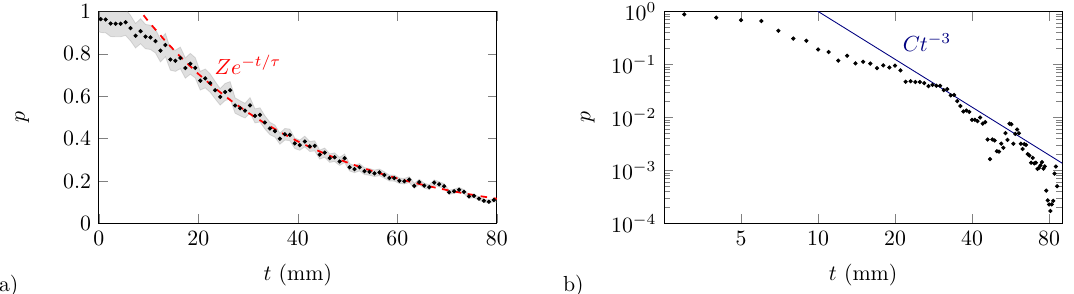
Figure 3. ( a ) Experimental survival probability in a weakly coupled system ( κ 0 < κ ). The measured points (black dots) are encircled by a gray area indicating the experimental uncertainty. ( b ) Experimental survival probability in a system with stronger coupling ( κ 0 asymptotic